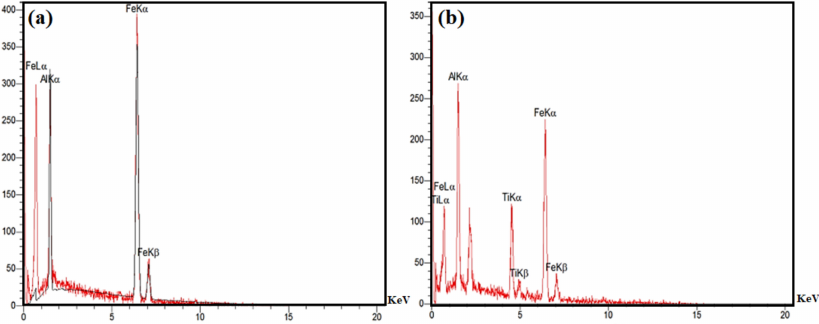
Figure 5. EDS analysis of the bulk samples (after SPS process); ( a ) Fe 3 Al and ( b ) (Fe, Ti) 3 Al compounds.